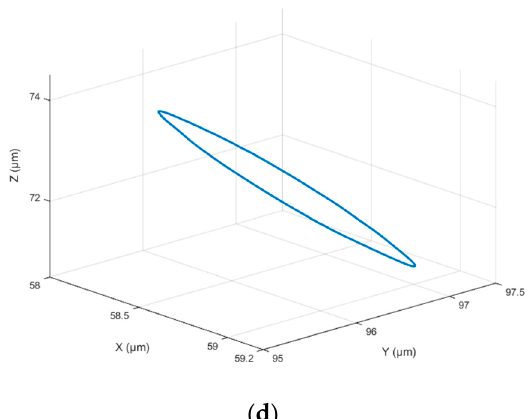
Figure 34. Experimental scenario 1. ( a ) x -direction input signal; ( b ) y -direction input signal; ( c ) z -direction input signal; ( d ) output trajectory.